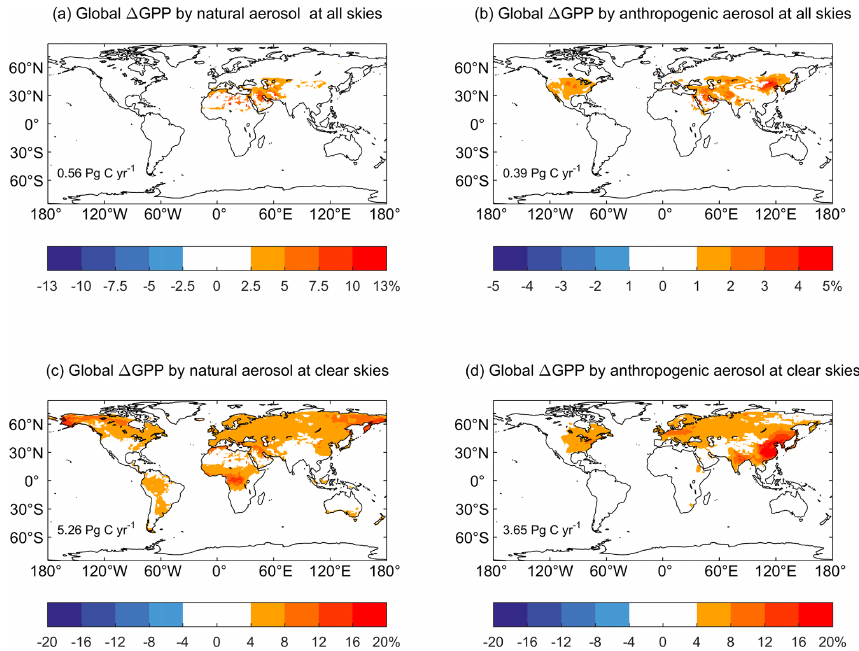
Figure 4. Percentage changes in annual GPP by (a, c) natural and (b, d) anthropogenic aerosols under (a, b) all-sky and (c, d) clear-sky conditions. The total changes in GPP caused by different aerosol sources are shown in corresponding panels. Please notice that the color scales for natural and anthropogenic aerosols are different. The units are